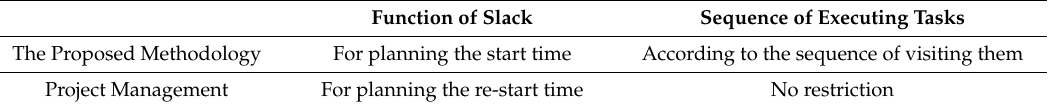
Table 6. Di ff erences between the proposed methodology and project